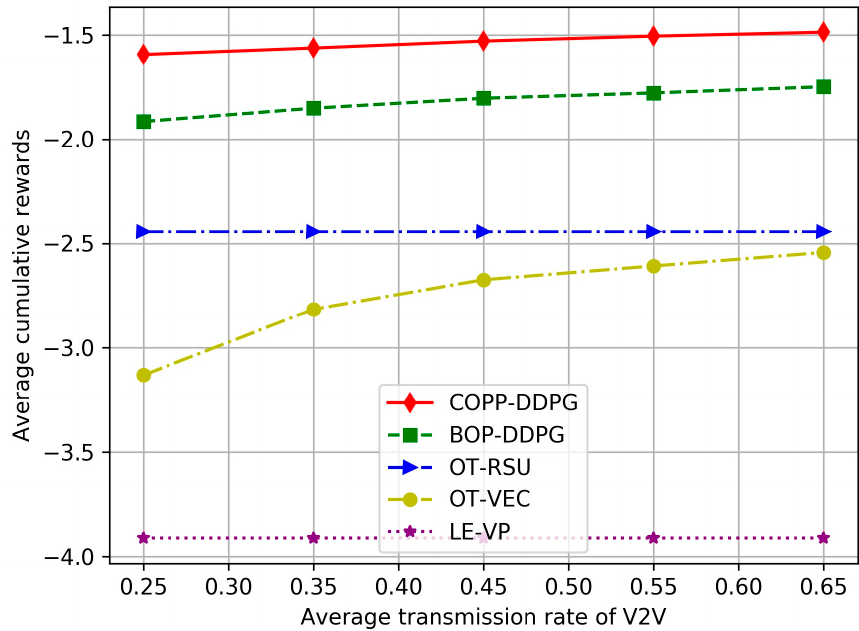
Figure 8. Comparison of all algorithms with different transmission rates of V2V.